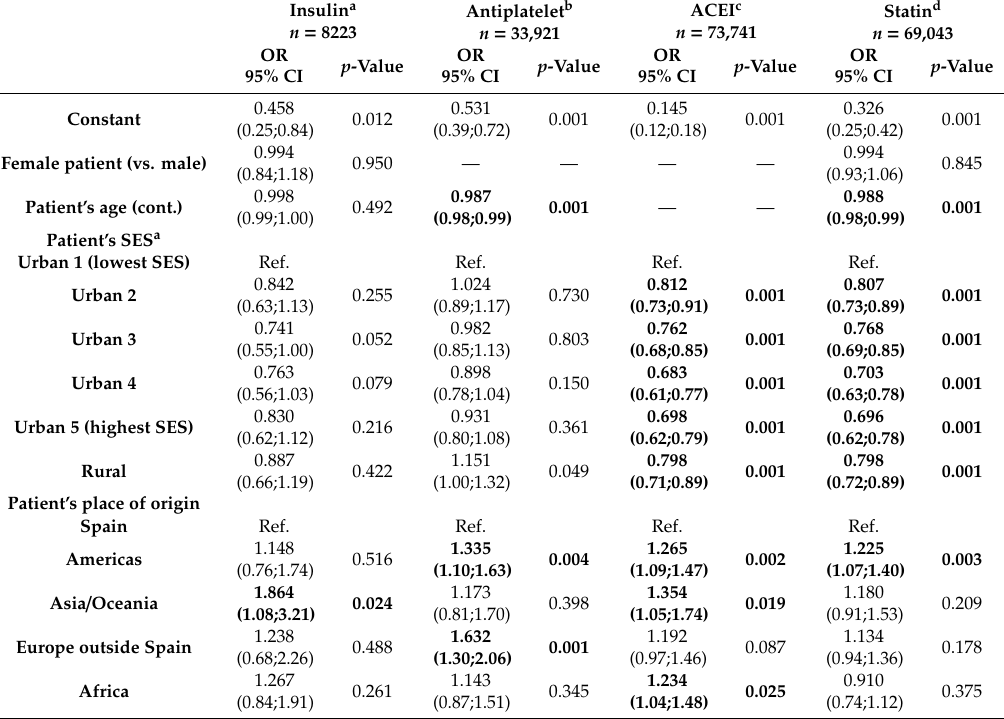
Figure 1. Factors that increase/decrease the probability of non-initiation after 3 months ( ▲ / ▼ ) and 6 months ( ↑ / ↓ ) and of single dispensing within a 3-month period ( (cid:52) / (cid:53) ). Table 3. Explanatory factors of non-initiation after 3 months based on multivariate multilevel